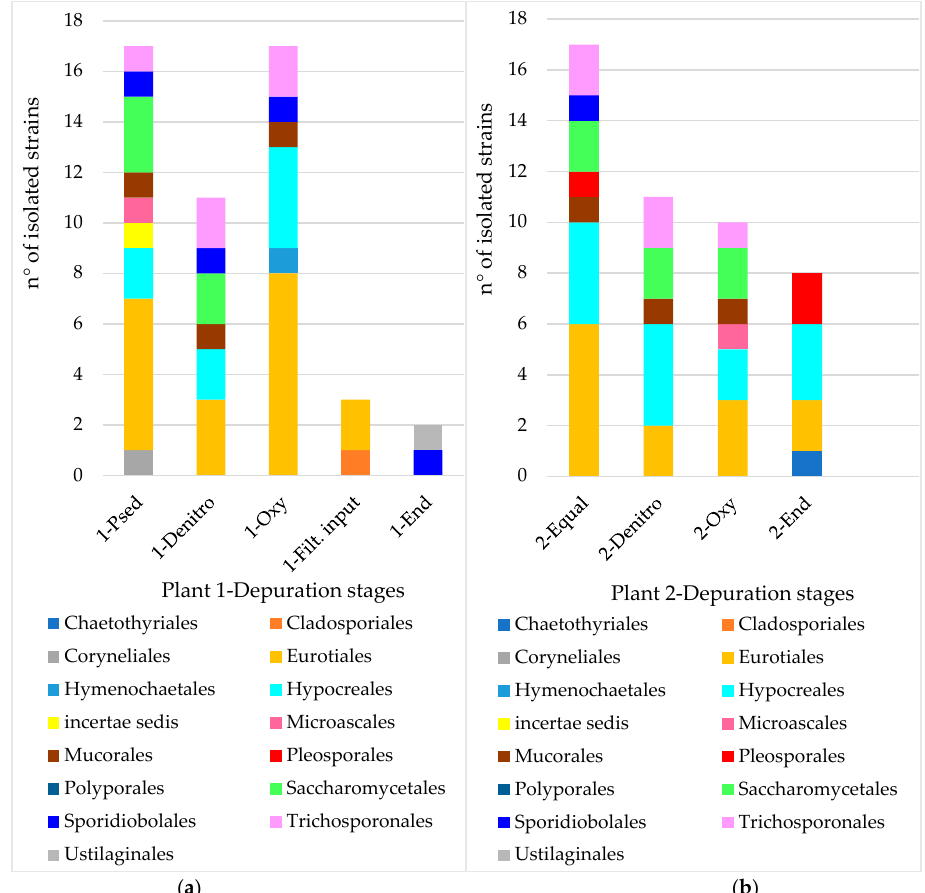
Figure 3. Diversity pattern of the isolated strains at an Order scale in Plant 1 ( a ) and Plant 2 ( b ) with reference to the depuration stage of provenance. Among all isolated strains, Eurotiales is the most represented in both the treatment plants and in almost all depuration stages. In this study, Eurotiales include Aspergillus and Penicillium or Talaromyces , as well as Paecilomyces . It should be noted that the nomencla- tural distinction between Penicillium and Talaromyces has been adopted, despite the fact that they are the anamorph and teleomorph of the same taxon, respectively. This decision was taken to preserve the information about the occurrence of species which are known to reproduce sexually as well. Furthermore, Hypocreales constitutes the base of the fungal community in this study, as species belonging to this order have been sampled in three out of five depuration stages in Plant 1 and in all stages in Plant 2. Fusarium and Trichoderma , which are very common in agricultural systems and soils, are the most represented species. A special mention is deserved by Trichoderma , whose species play an important role in soil ecology due to their competition and hyperparasitism versus phytopathogens (mainly fungi and nematodes).